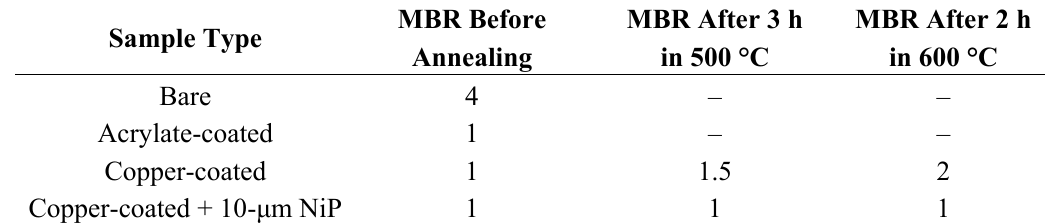
Table 4. Results of the minimum bending radius (MBR) tests (before annealing, 500 °C for 3 h, 600 °C for 2 h). All numbers are given in